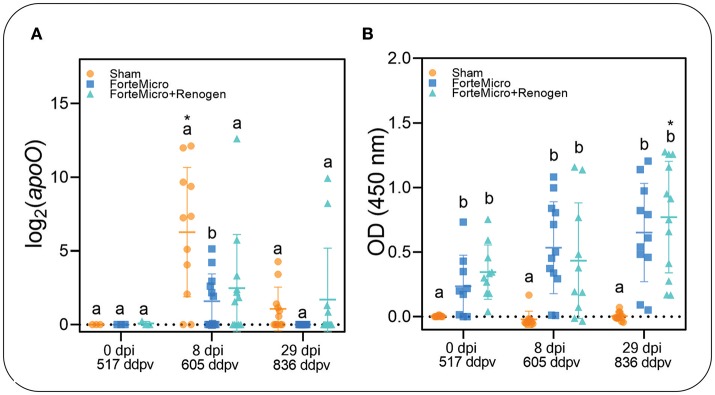
(A) Transcript abundance of Asal apoO gene was quantified over time in head kidney of vaccinated and unvaccinated Arctic charr prior to and after i.p.-injection (8 and 29 dpi). There was significantly higher expression in PBS-injected controls compared to either vaccine group at 8 dpi. At 29 dpi, expression decreased in controls to the same levels as vaccinated fish. Scatterplots are showing all samples with the mean denoted by the hashmark (n = 12) and the error bars indicating the standard deviation. Significance was determined by 2-way ANOVA followed by post-hoc Tukey's HSD (p < 0.05). Lower-cased letters denote significant differences among groups at each time point, while asterisk denotes differences over time within the same group. (B) Concentration of Asal-specific antibodies in charr plasma were measured by ELISA. Data shown are from 1:125 (PBS-control) and 1:5,000 (FM- and FM+R-vaccinate groups) dilution of serum samples (n = 9, per group). Statistical significance was determined using a two-way ANOVA followed by Tukey post-hoc HSD (P < 0.05). There was a significant difference between control and either FM- or FM+R-vaccinated charr at all-time points (p < 0.001).